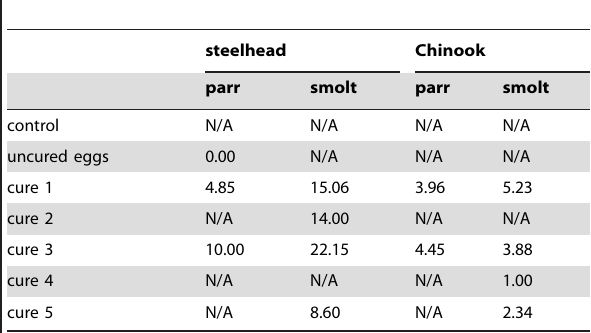
Table 2. Post-mortem evaluation of cured egg